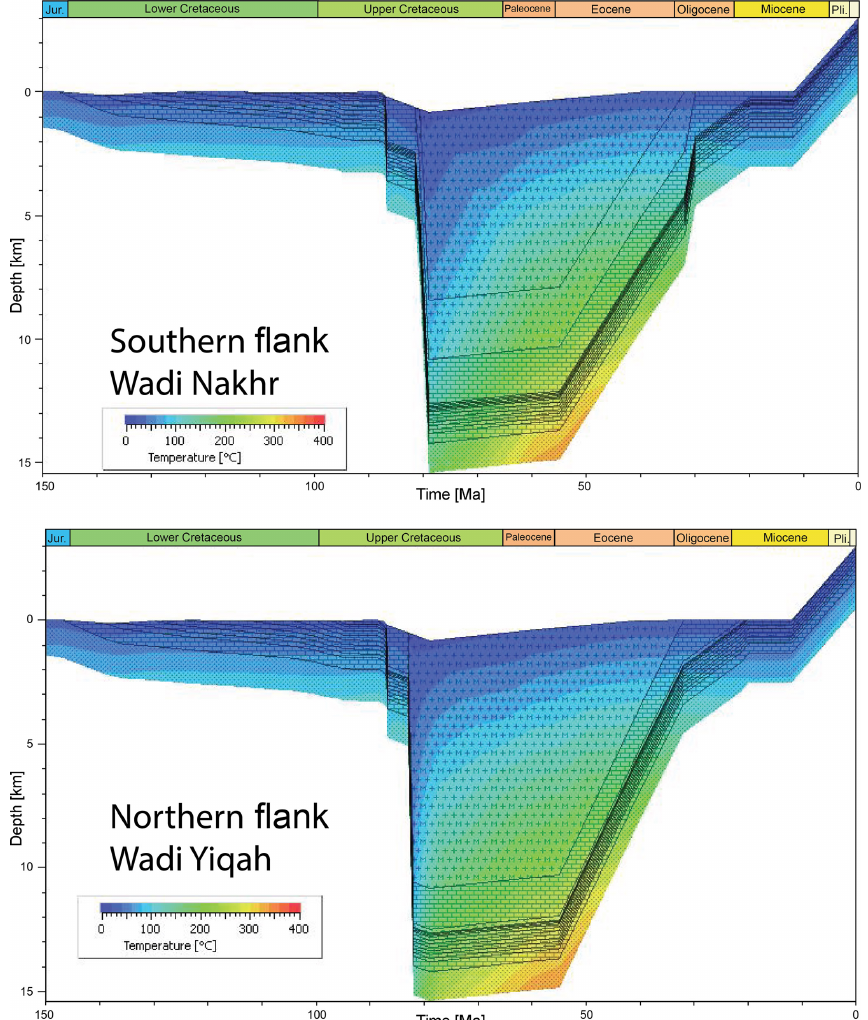
Figure 8. Modeling results: two representative burial plots for two pseudo-wells created near the entrances of Wadi Nakhr and Yiqah (Figs. 1, 6, and 7) show two phases of rapid burial related to Hawasina and Semail nappe emplacement at ca. 88Ma and ophiolite emplacement at ca. 78Ma. Burial in the north (Wadi Yiqah) starts ca. 2Myr earlier due to ophiolite obduction taking place from N to